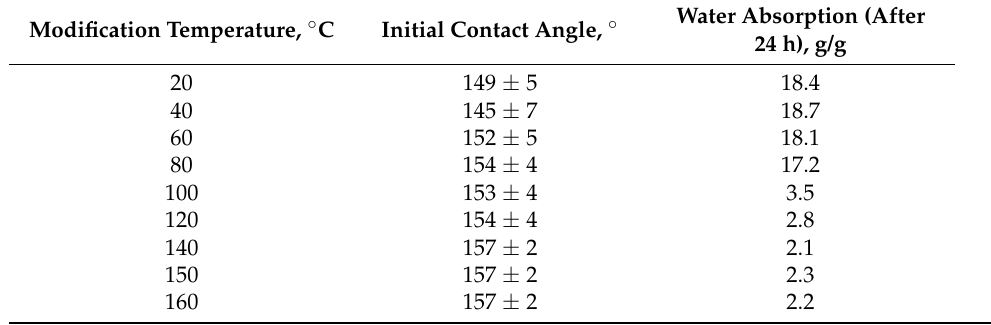
Table 7. Initial contact angle and water absorption of chitosan aerogels modified for 1 h using poly(GMA-co-TDMA) solutions with 0.1 wt% concentration at varying temperatures.